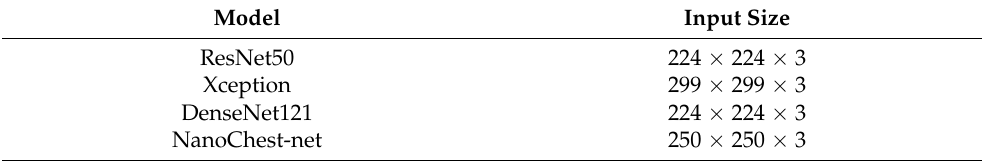
Table 4. Input size for each CNN